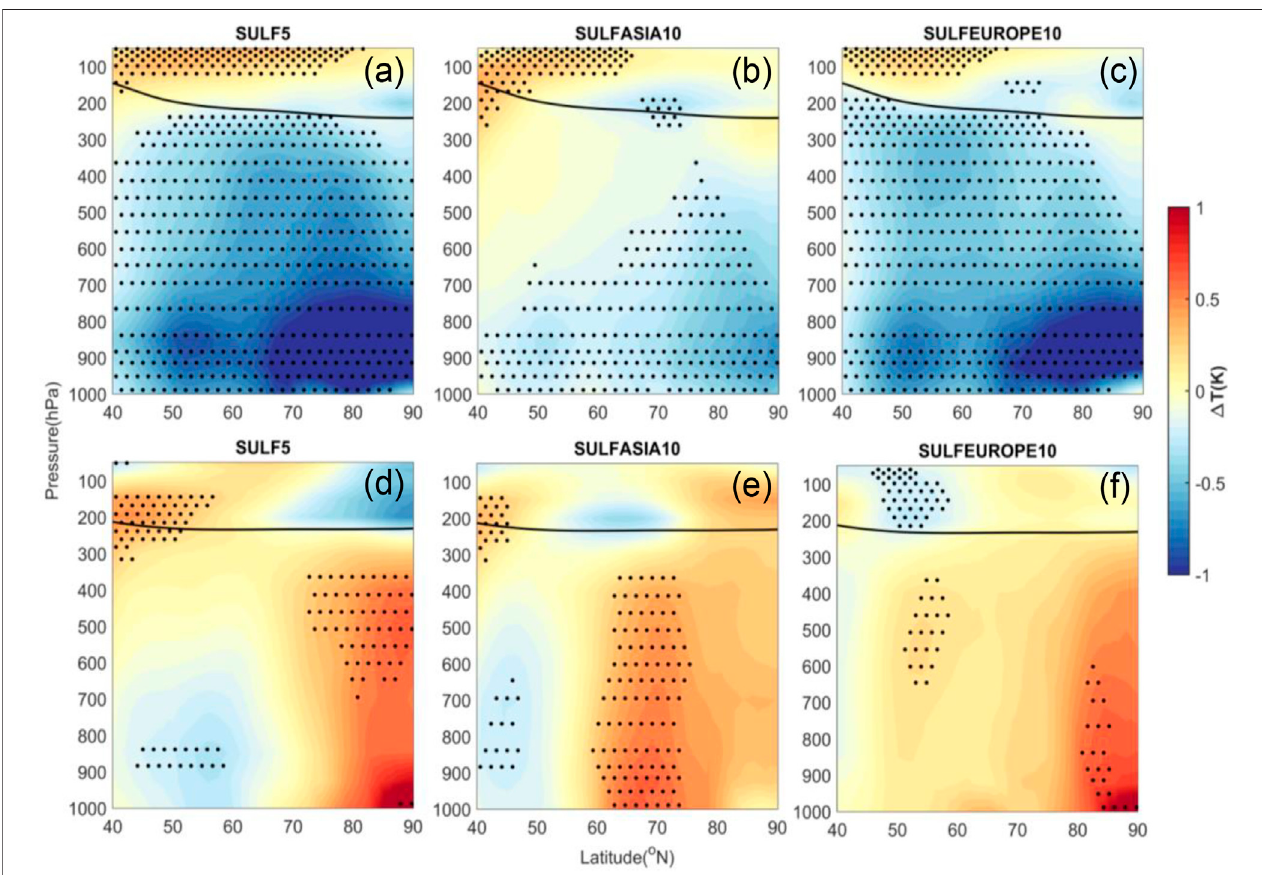
FIGURE 4 | Zonal mean latitude-height plot of air temperature anomalies for summer (A – C) and winter (D – F) . Stippling indicates statistical signi fi cance at 90% con fi dence level (EXPT-CTRL) determined using student ’ s t-test for the difference of the mean. The black line indicates the climatological tropopause (CTRL) for corresponding